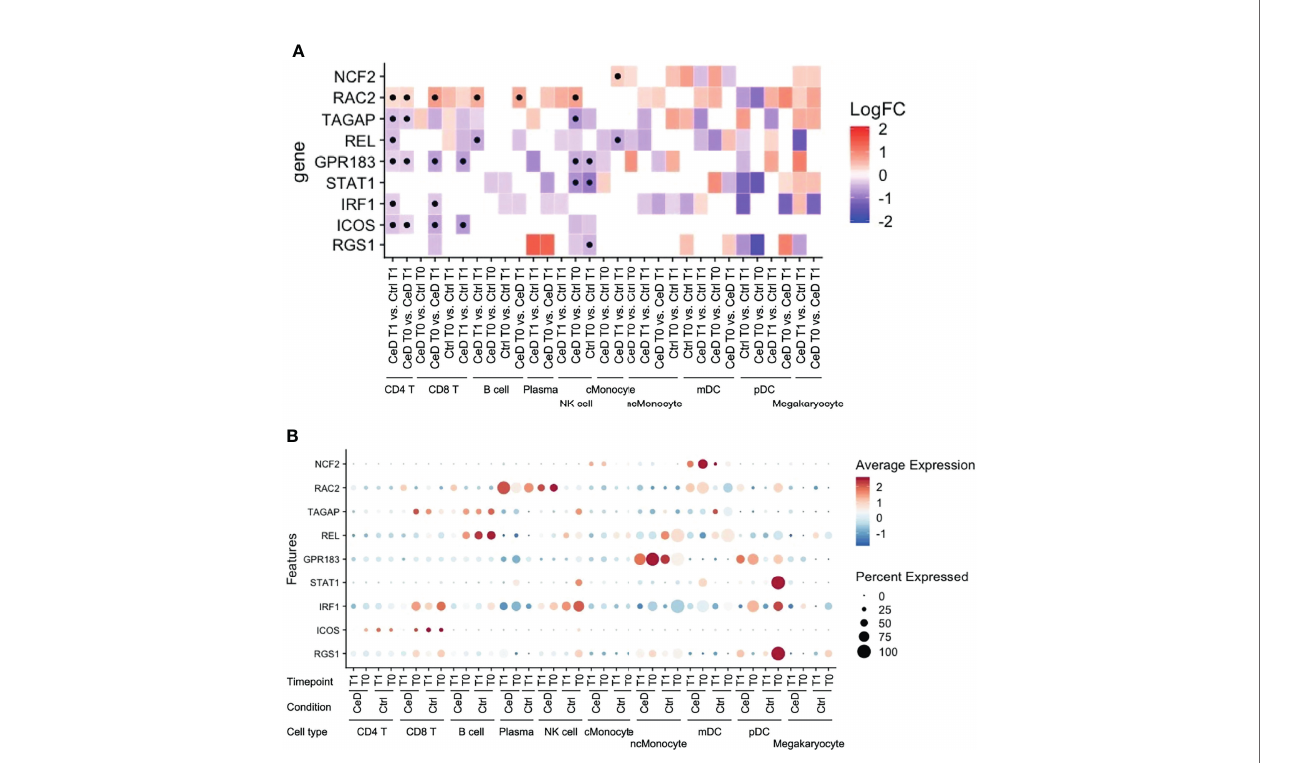
FIGURE 7 | Expression pattern of GWAS-associated CeD genes. (A) Heatmap with the log2FC of all intersected DEGs with the 118 risk genes prioritized from CeD loci from v. d. Graaf et al. (24). Vertical axis shows the name of the genes. Horizontal axis corresponds to the different comparisons performed per cell type, timepoint and condition. Black dots indicate whether the gene is signi fi cant (adjusted p-value < 0.05). (B) Dotplot of the intersected DEGs to the prioritized genes to show the relative average normalized expression of the genes in the different groups and cell types. (similar to Figure 5